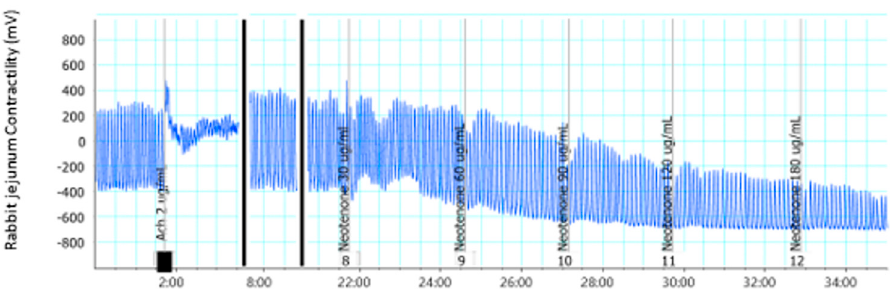
Figure 4. Effect of compound 7 on isolated rabbit jejunum.